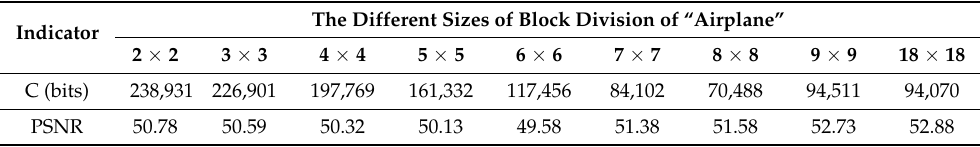
Table 3. Comparison of embedding capacity using different block sizes of Airplane.